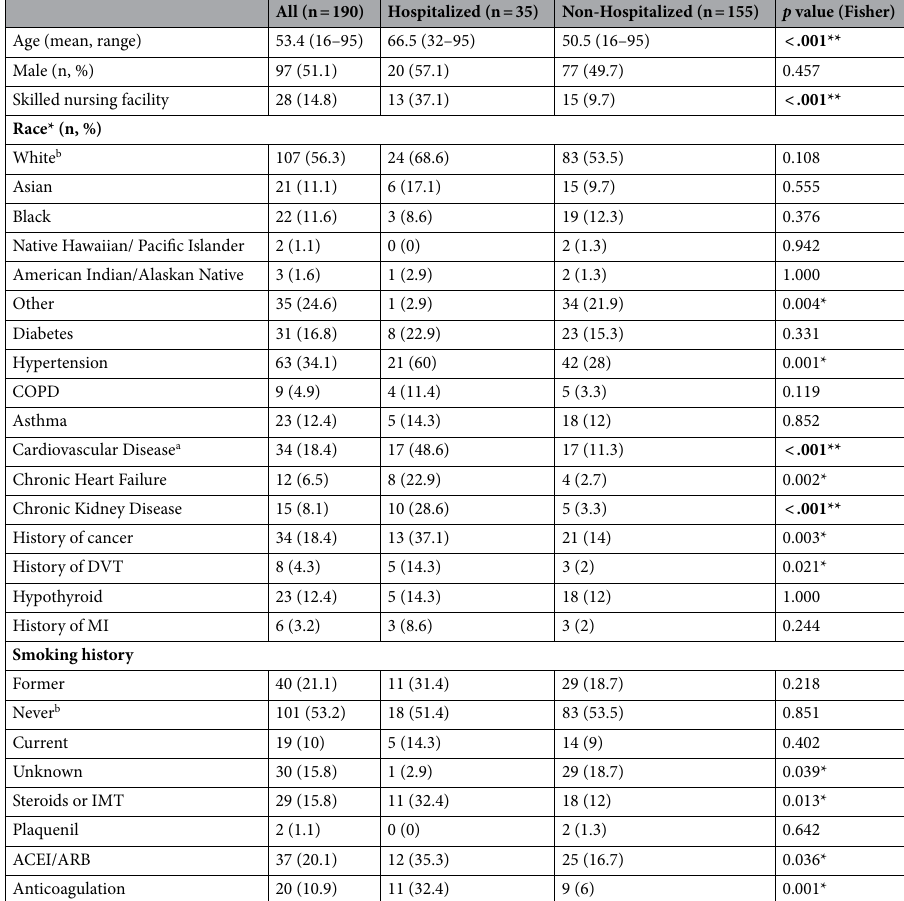
Table 1. Baseline demographics and medical histories of hospitalized and non-hospitalized patients. DVT Deep Venous Thrombosis, COPD chronic obstructive pulmonary disease, MI myocardial infarction, ACEI b Reference value. All diseases were defined using ICD-9 and ICD-10